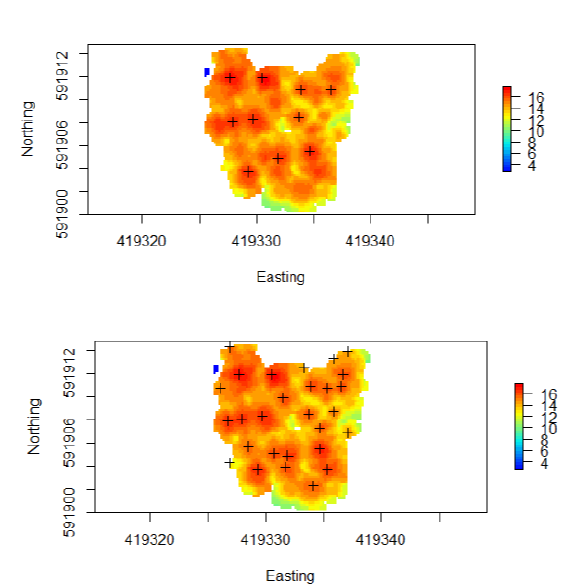
Figure 9. Canopy Height Model of Plot E with detected tree tops. Top: moving kernel size = 3m, bottom: moving kernel size =